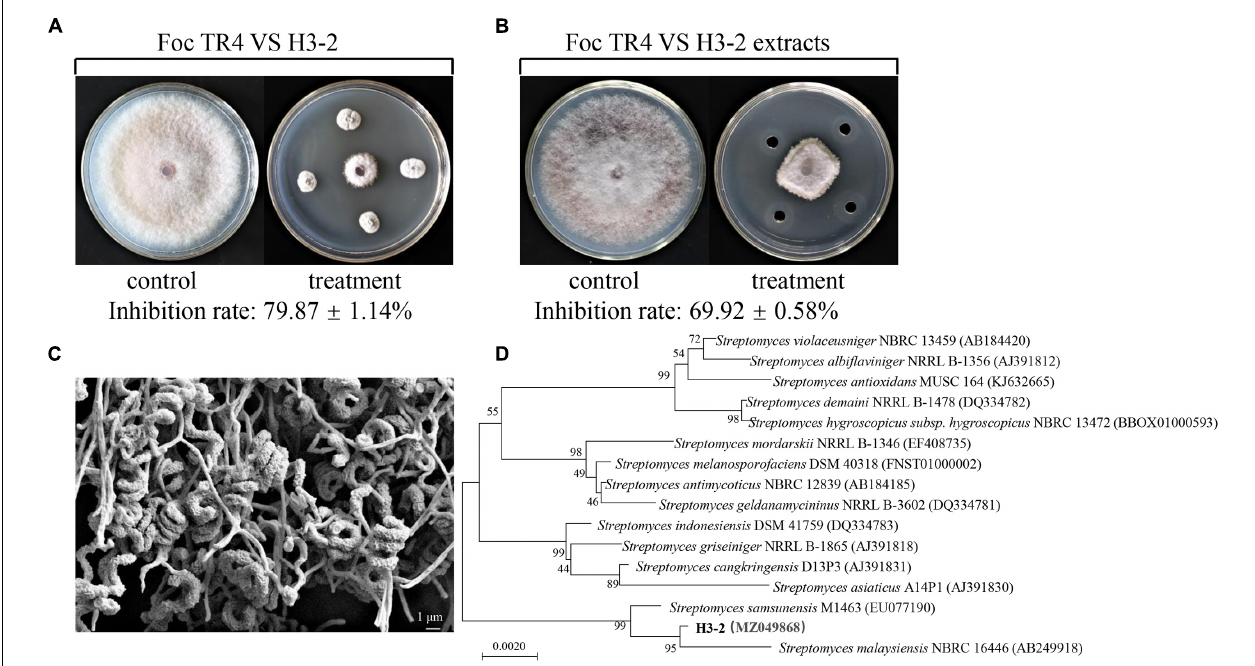
FIGURE 1 | Isolation and identification of strain H3-2 with high antifungal activity against Foc TR4. (A) Strain H3-2 inhibiting mycelial growth of Foc TR4. (B) Strain H3-2 extracts inhibiting mycelial growth of Foc TR4. (C) Morphological characteristics of aerial mycelia and spores of strain H3-2 using SEM. (D) Phylogenetic tree of strain H3-2 based on 16S rRNA gene sequence analysis. The bootstrap values (%) at the branches were calculated from 1,000